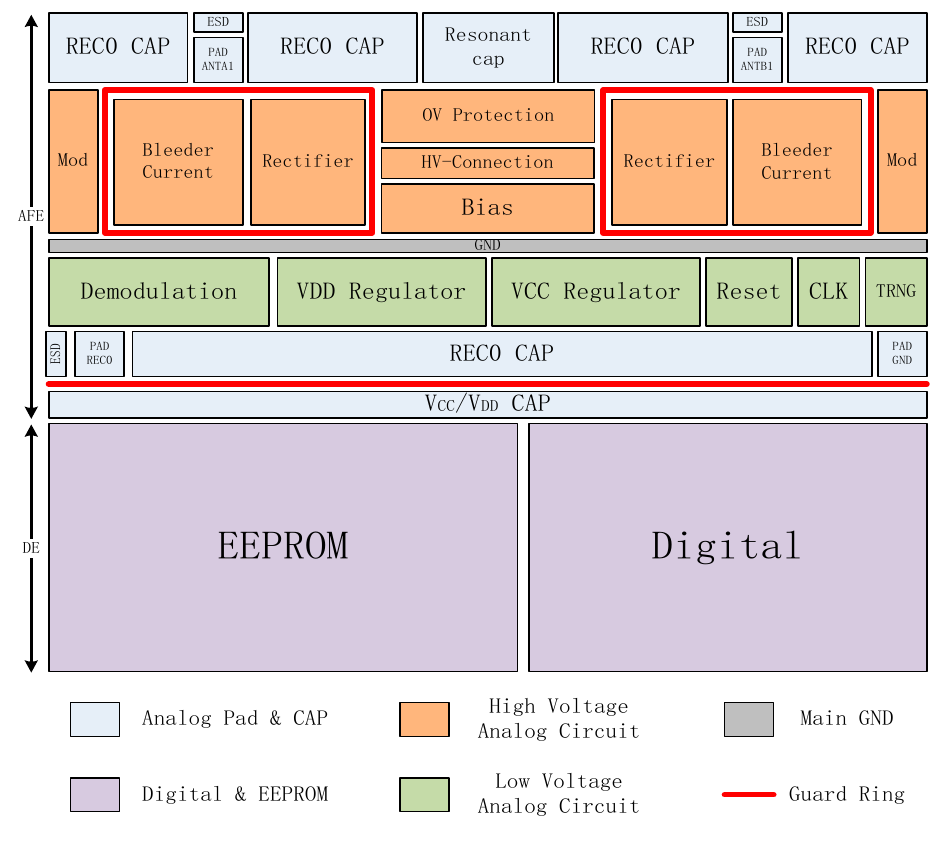
Figure 6. Layout floor plan of the whole